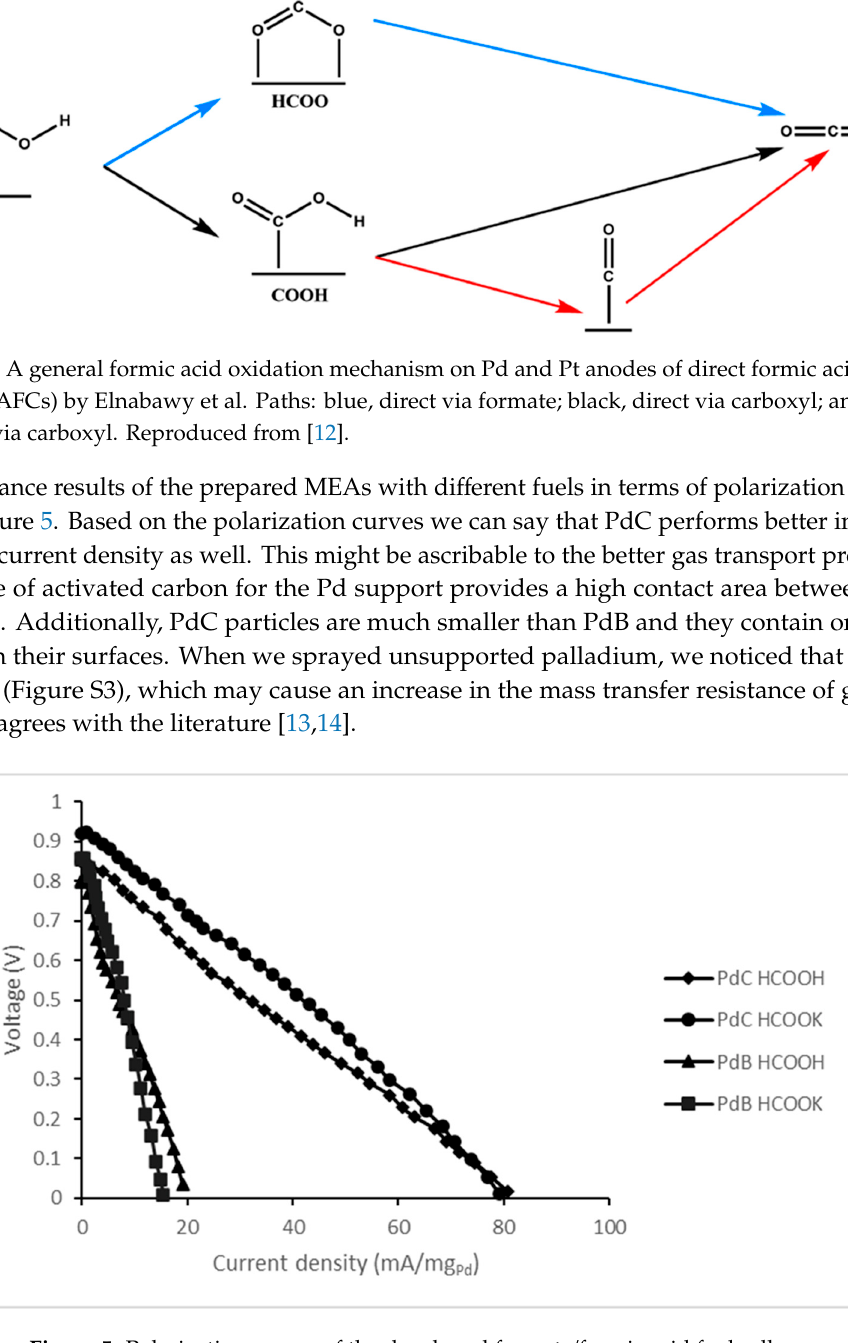
Figure 5. Polarization curves of the developed formate/formic acid fuel cells.